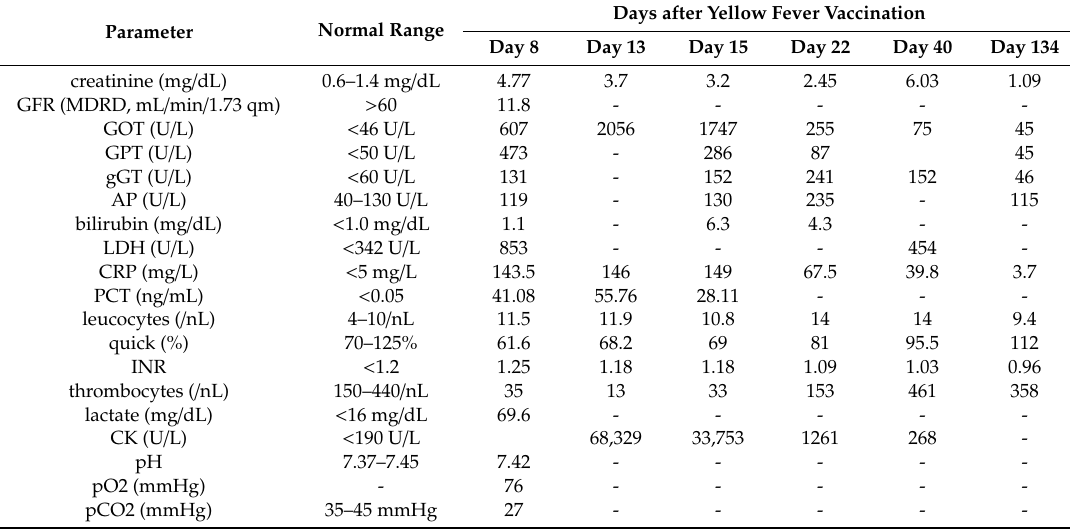
Table 1. Results of clinical chemistry parameters, values out of normal range are marked in bold.